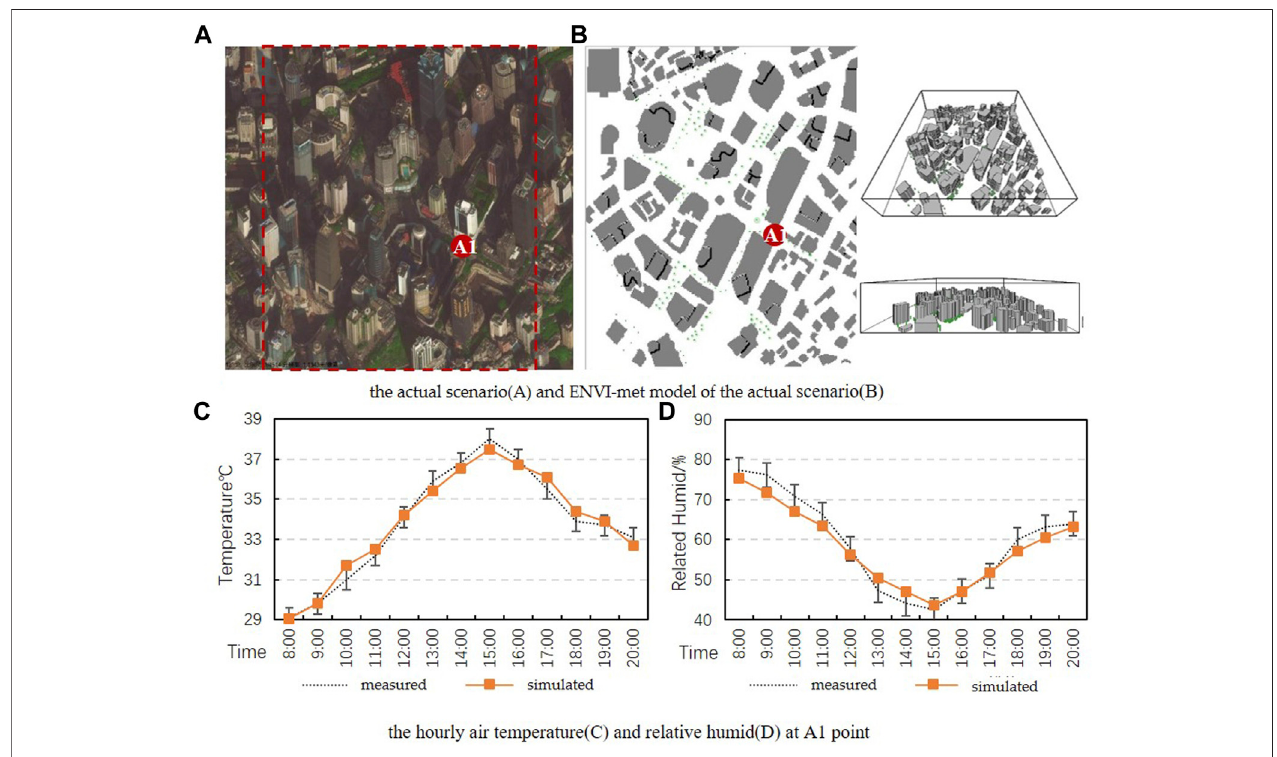
FIGURE 5 | The actual scenario (A) and ENVI-met model of the actual scenario (B) , the hourly air temperature (C) and the relative humidity (D) at A1.